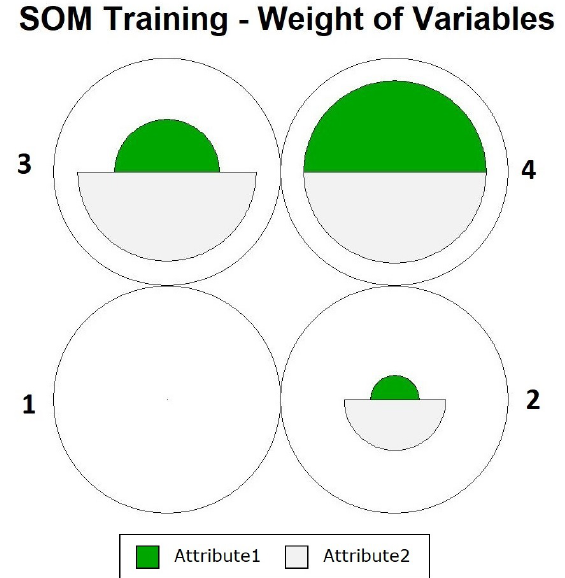
Figure 5. Attribute distribution—synthetic database.